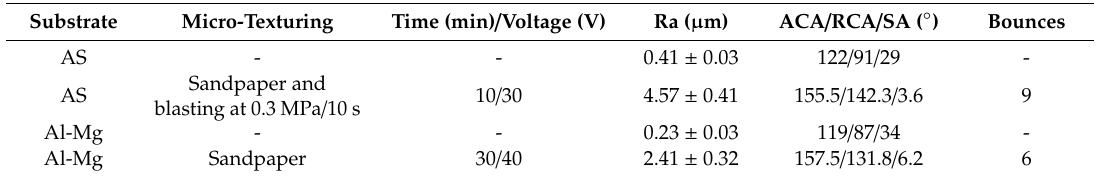
Table 2. Advancing contact angle (ACA), receding contact angle (RCA), SA, roughness (Ra), and number of bounces for the most representative samples after electrodeposition.